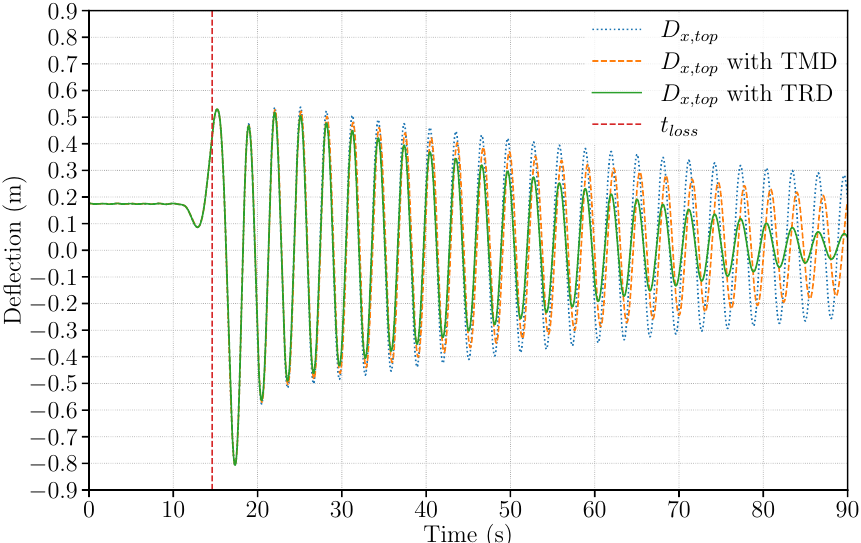
Figure 9. Tower-top fore-aft deflection at cut-out wind speed ( V out = 25.0m/s) with/without damper. At the end of simulation ( t = 90 s), the reference fore-aft deflection (blue dotted line) still oscillates between 0.26 m and 0.28 m. In the case of passive damper TMD − (orange dashed line), the vibration is limited between 0.17 m and 0.21 m. The peak-to- − peak amplitude is reduced by 30% according to Equation (40). In the case of the active damper TRD (green line), the vibration is stabilized between 0.03 m and 0.06 m. That is a − reduction of 83% in terms of peak-to-peak